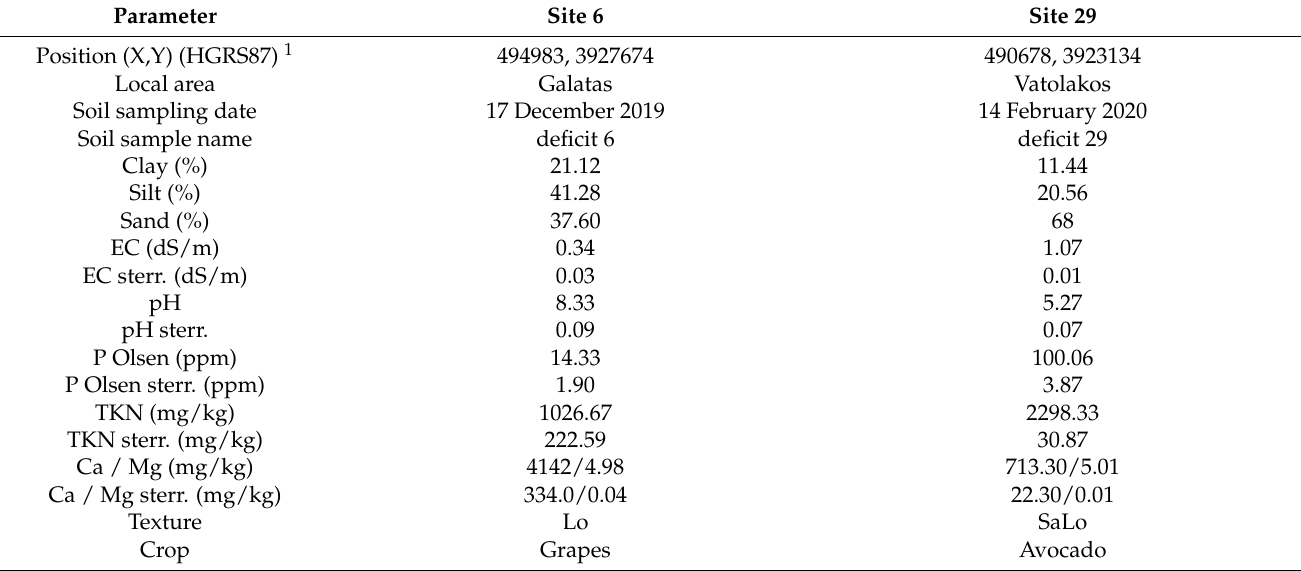
Table A1. Collected data from sites #6 and